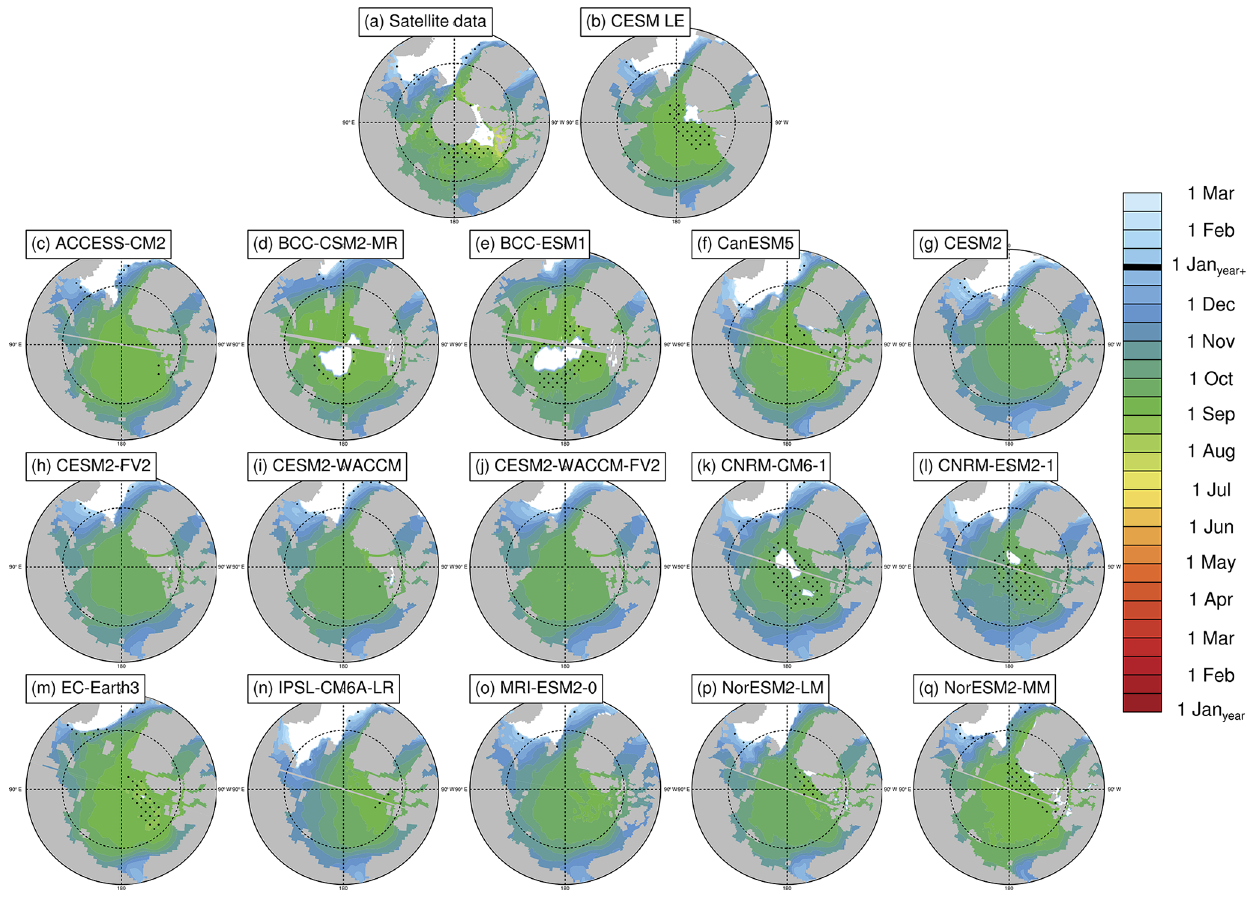
Figure 7. Closing dates (ice passes the 80% ice concentration threshold) averaged over the period 1979–2014 at each grid cell using satellite data (a) , the first ensemble member of the CESM LE (b) , and the first ensemble member of each CMIP6 model (c–q) . Stippling indicates where closing dates exist in less than 20% of years in the time range. Models on tripolar grids produce plot gaps filled by gray